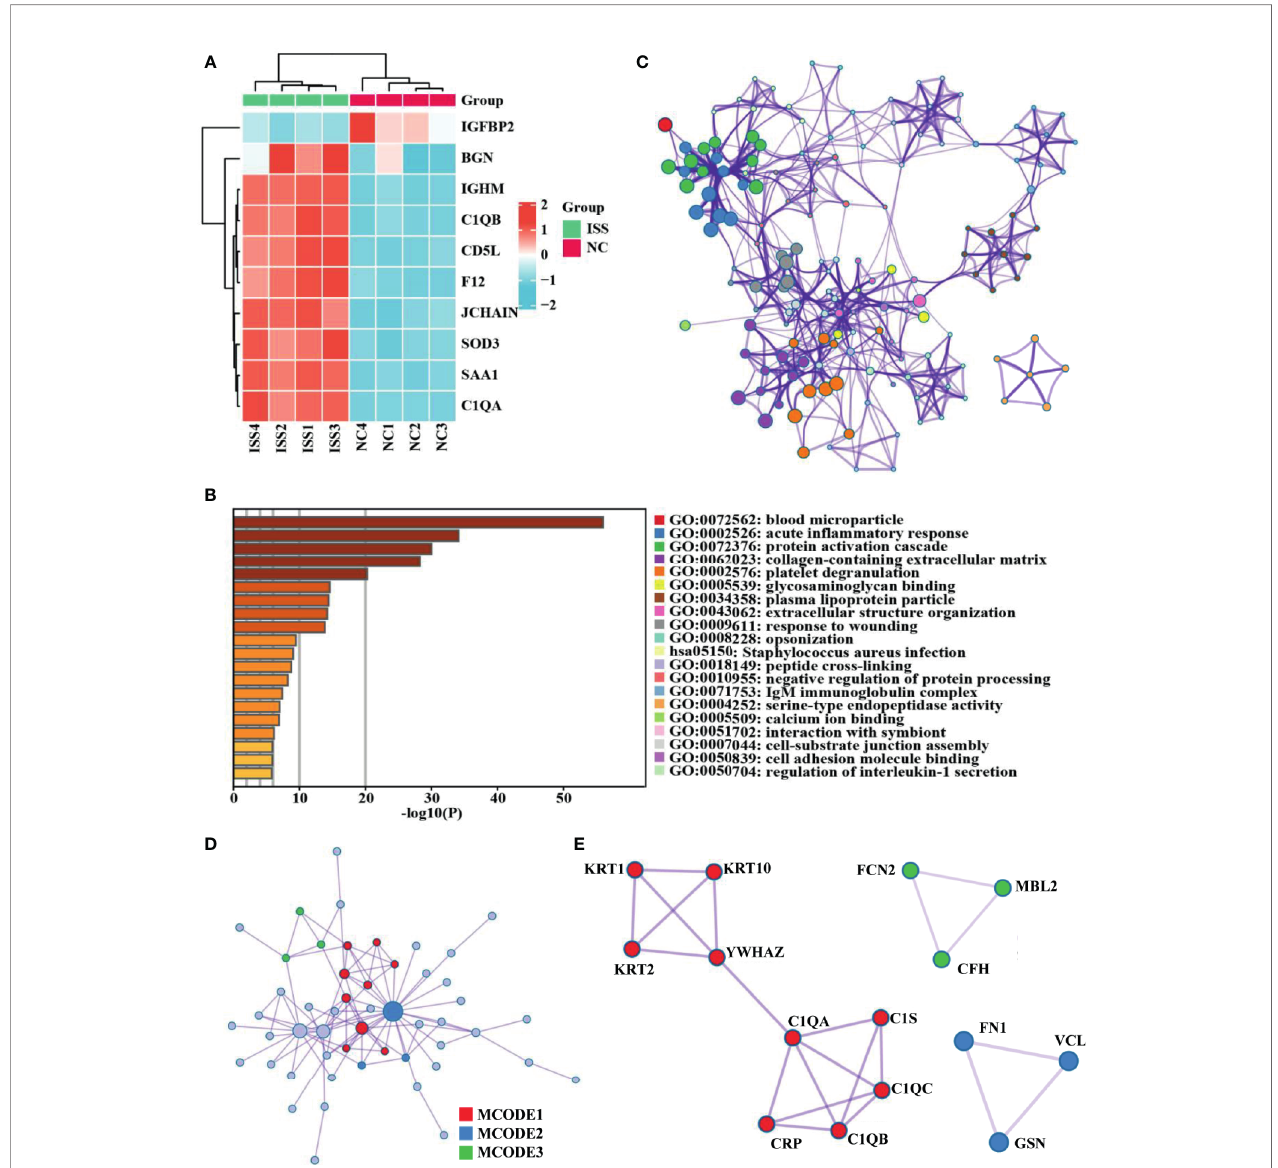
FIGURE 1 | Differential expression proteins analysis and crucial proteins selected. (A) A clustering heat map of the top 10 fold change for differentially expressed proteins (DEPs) patterns of ISS and negative control (NC) groups. Red color indicates higher expression, while blue indicates lower expression. Proteins without signi fi cantly differential expression are shown in white. (B) Signi fi cant functional enrichment analysis results of DEPS via Metascape database. (C) Enrichment network plot of DEPS constructed by Cytoscape software. (D, E) Results of MCODE ’ s subnetwork analysis of the PPI network; three key subnetworks were obtained, namely, MCODE 1 (red), MCODE 2 (blue), and MCODE 3